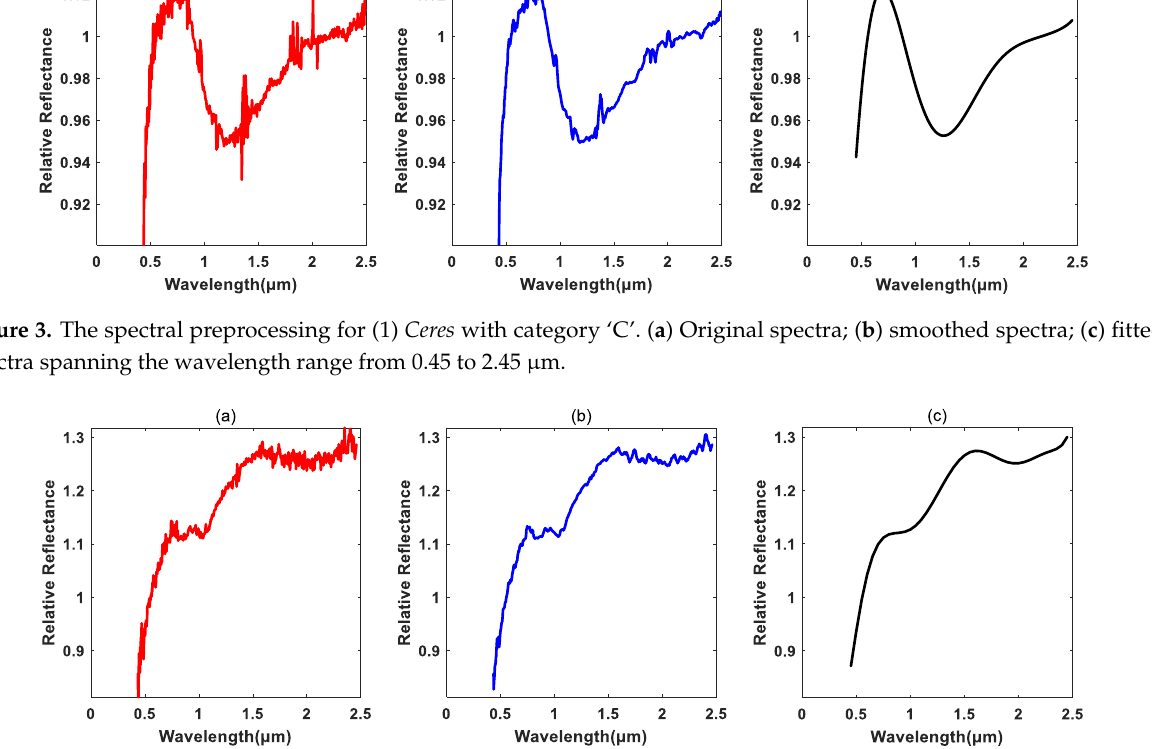
Figure 4. The spectral preprocessing for (2957) Tatsuo with category ‘K’. ( a ) Original spectra; ( b ) smoothed spectra; ( c ) fitted spectra spanning the wavelength range from 0.45 to 2.45 μ m.